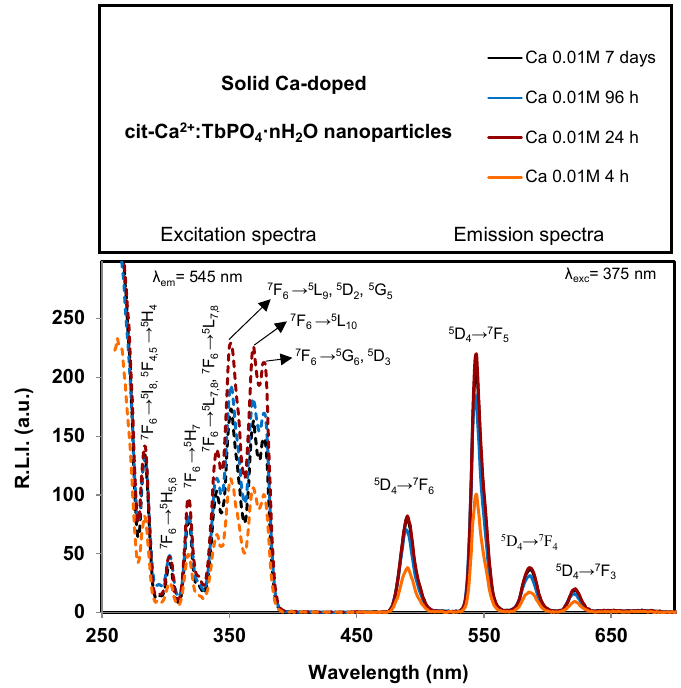
Figure 6. Excitation (dashed lines) and emission (solid lines) uncorrected spectra of solid cit- Ca 2+ :TbPO 4 · nH 2 O samples prepared with x = 0.01 M Ca 2+ at maturation times of 4 h, 24 h, 96 h and 7 days.